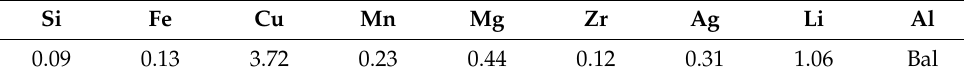
Table 1. Chemical composition of Al-Cu-Li alloy (mass fraction/%).